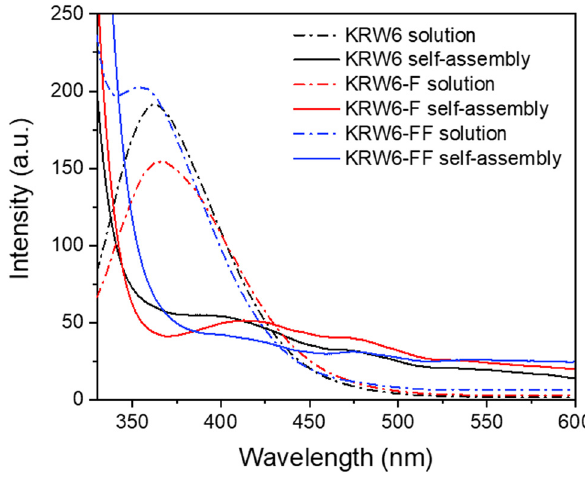
Figure 3: Fluorescence spectra of KRW6, KRW6 - F, and KRW6 - FF peptide solutions ( 40 mg · mL − 1 , pH = 3 ) and peptide self - assemblies.